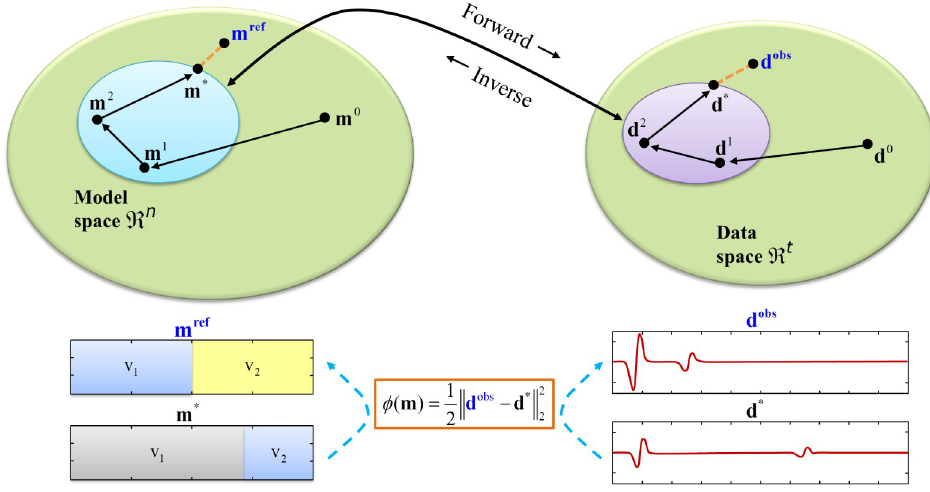
Fig 1. Forward and inverse problems and misfit function. The FWI iterative process solves the inverse seismic problem by successively applying the direct seismic problem, fitting the model to the data, until the misfit is minimal.